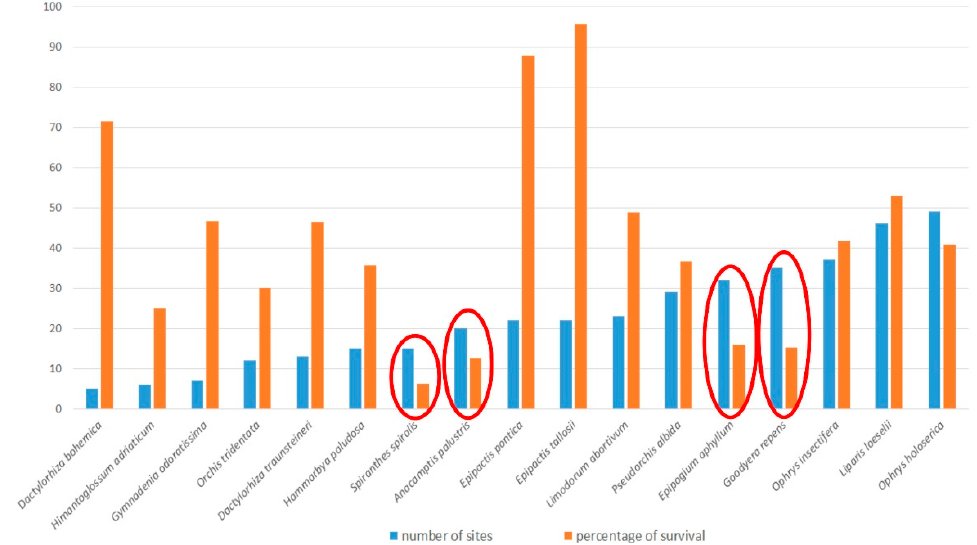
Figure 7. The highly threatened species of orchids in the Czech Republic with less than 50 sites recorded in the last period, ranked in order of the number of occupied sites in the last period. For each species, the percentage survival (orange bars in the figure) is the percentage of its sites included in the database that have survived until now (were found to be occupied during the last period). The orchid species circled in red are considered to be the most endangered species in the Czech flora (see text for explanation).